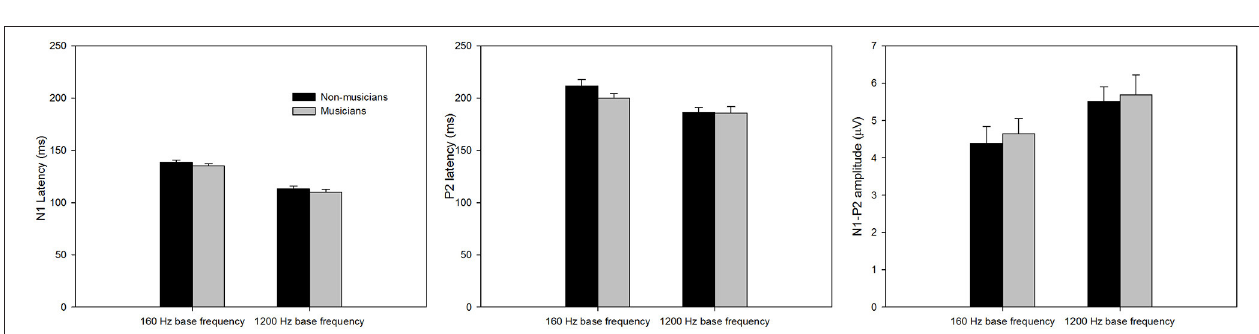
FIGURE 3 | The onset LAEP measures (N1 latency, P2 latency, and N1-P2 amplitude) for musicians and non-musicians. The error bars indicate standard errors of the means.